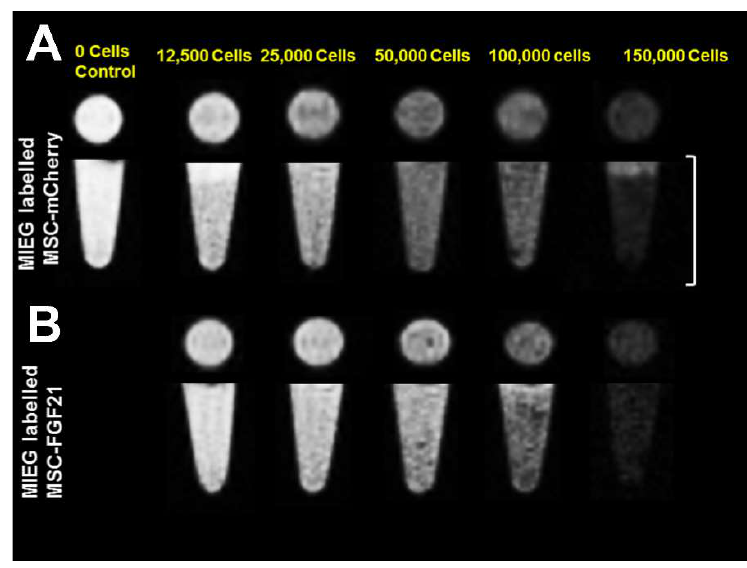
Figure 5. Magnetic resonance imaging (MRI) of a phantom injected with 100 µ L of gelatin containing MIEG-labeled MSCs. The images were captured using T2*weighted imaging (T2*WI) based on spin echo. ( A ) MIEG-labeled MSC-mCherry and ( B ) MSC-FGF21 are visualized as hypointense areas in the isointense milieu. Images captured are presented in axial projection (upper panels) and coronal projection (lower panels). The scale bars represent 10 mm.